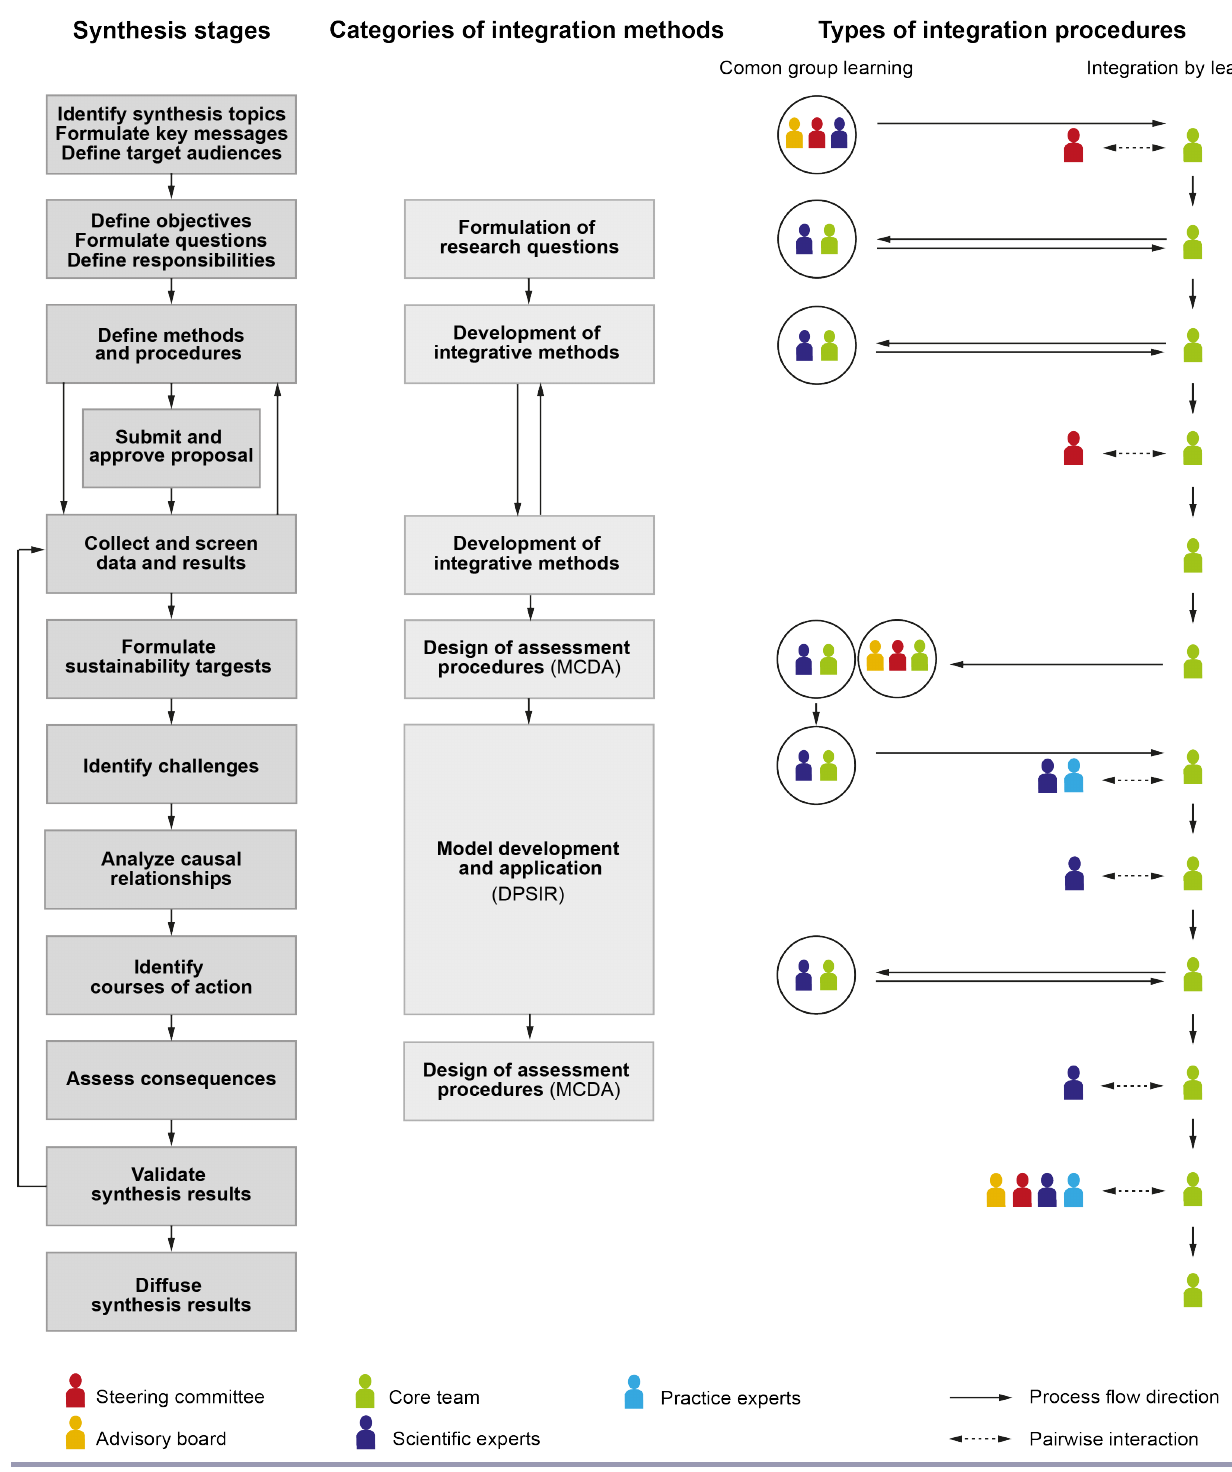
Fig. 2. Overall integration strategy of thematic synthesis 3, differentiated by synthesis stages, integration methods, and integration procedures. MCDA = multicriteria decision analysis, DPSIR = driver, pressure, state, impact, response. See Appendix 1 for the corresponding figures for TS-1, TS-2, and TS-4 (Figs. A1.1, A1.2, and A1.3,